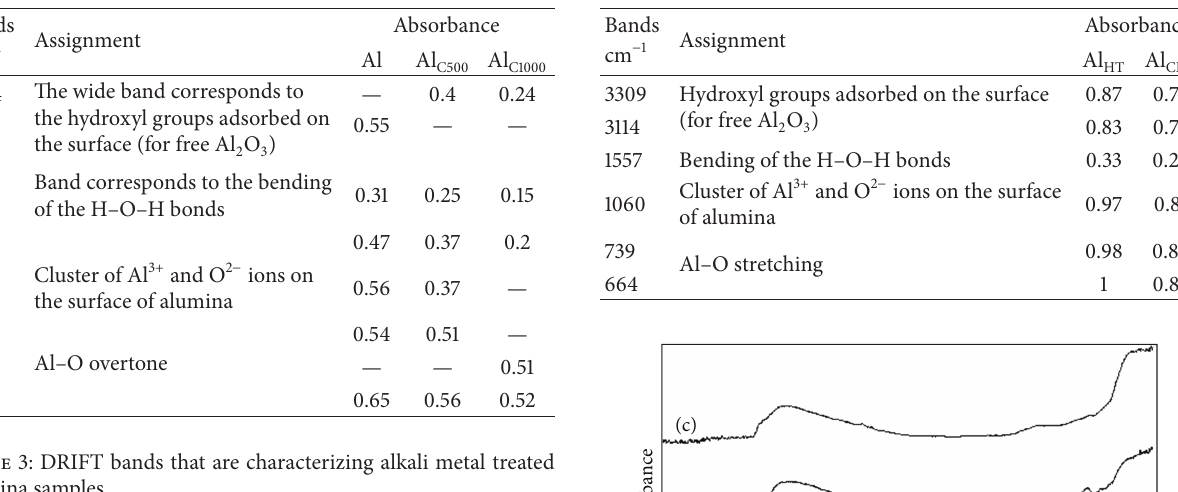
Table 2: DRIFT bands that are characterizing parent and thermally treated alumina samples.